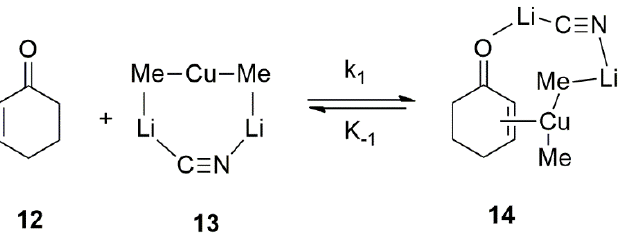
Figure 14. Investigation on Mechanism of Cu-catalyzed conjugate addition of Organocuprates using Rapid-injection NMR techniques.